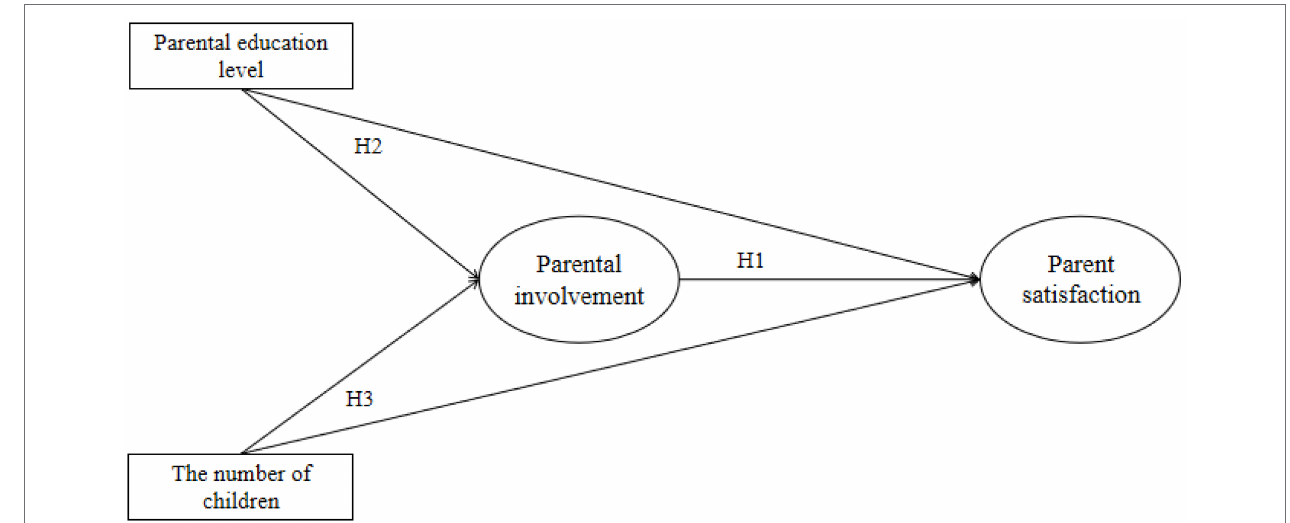
FIGURE 1 | Moderating model.